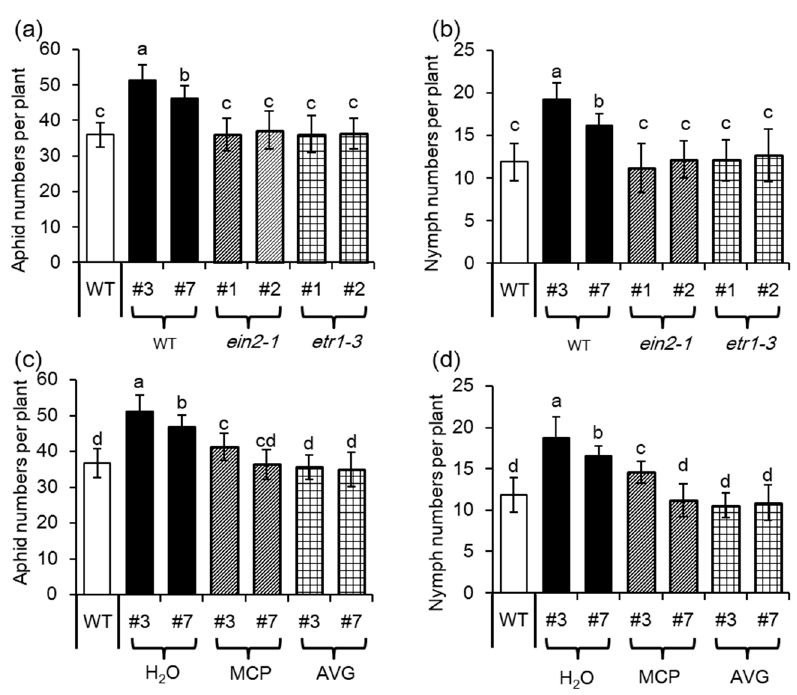
Figure 8. ET signaling is essential for increasing Arabidopsis susceptibility to aphids conferred by overexpression of MYB102 . ( a ) Population size (adults plus nymphs) of adult aphids on WT, MYB102-OX lines, MYB102-OX / ein2–1 , and MYB102-OX / etr1–3 ( n = 10) after 48 h of infestation, and ( b ) the number of progeny nymphs reared on these plants was measured after 10 days of nymph infestation ( n = 10). ( c ) Population size (adults plus nymphs) of adult aphids on both the WT and MYB102-OX lines, MCP - or AVG-treated MYB102-OX lines after 48 h of infestation, and ( d ) the number of progeny nymphs was calculated after 10 days of nymph infestation ( n = 10). Different letters above bars denotes significant difference among different treatments using Tukey’s test at p < 0.05.